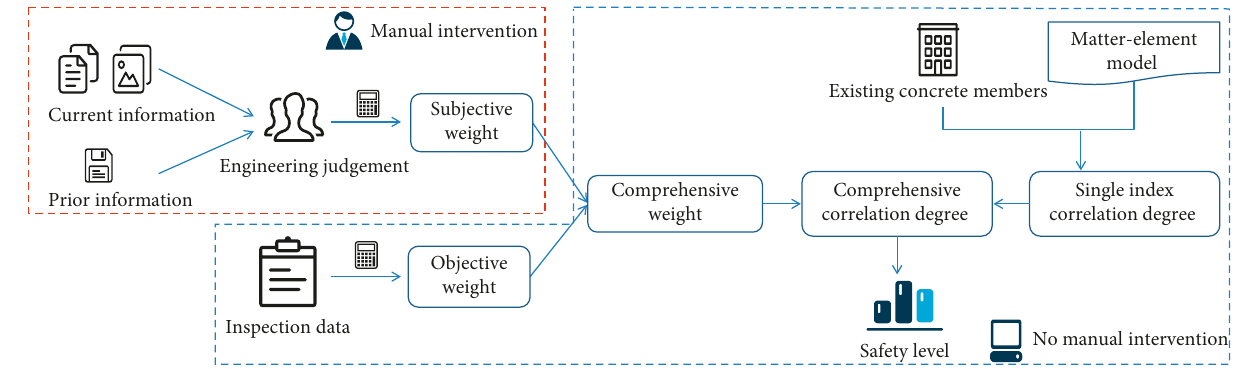
Figure 4: Extension model based on comprehensive weight.